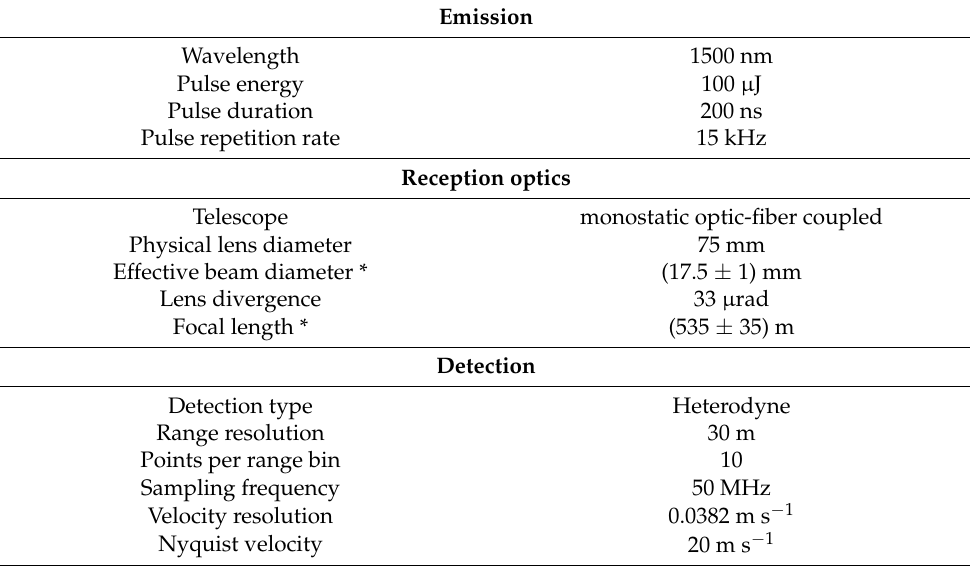
Table 1. Technical details of the main optical elements of the Doppler lidar